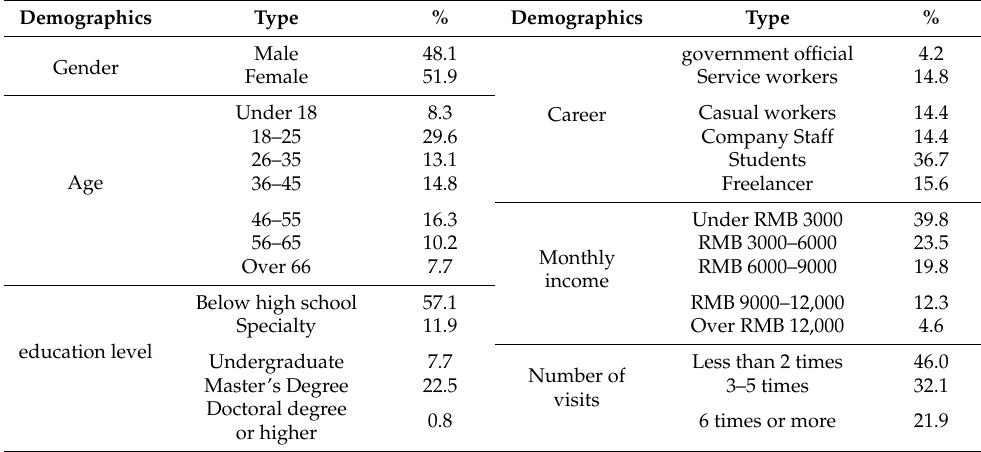
Table 1. Sociological characteristics of the